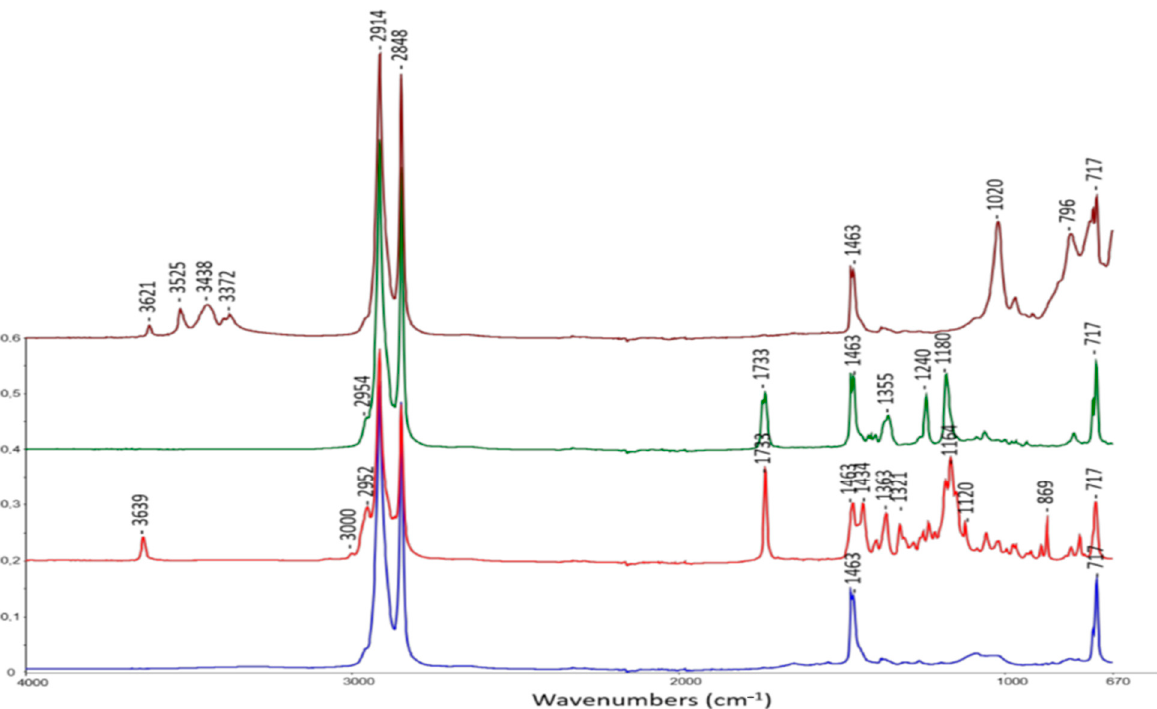
Figure 2. Attenuated total reflectance-Fourier transform infrared (ATR-FTIR) spectra of unaged materials: crosslinked polyethylene (XLPE, blue), XLPE + Irganox 1076 (red), XLPE + Irganox PS802 (green) and XLPE + alumina trihydrate (ATH, brown).